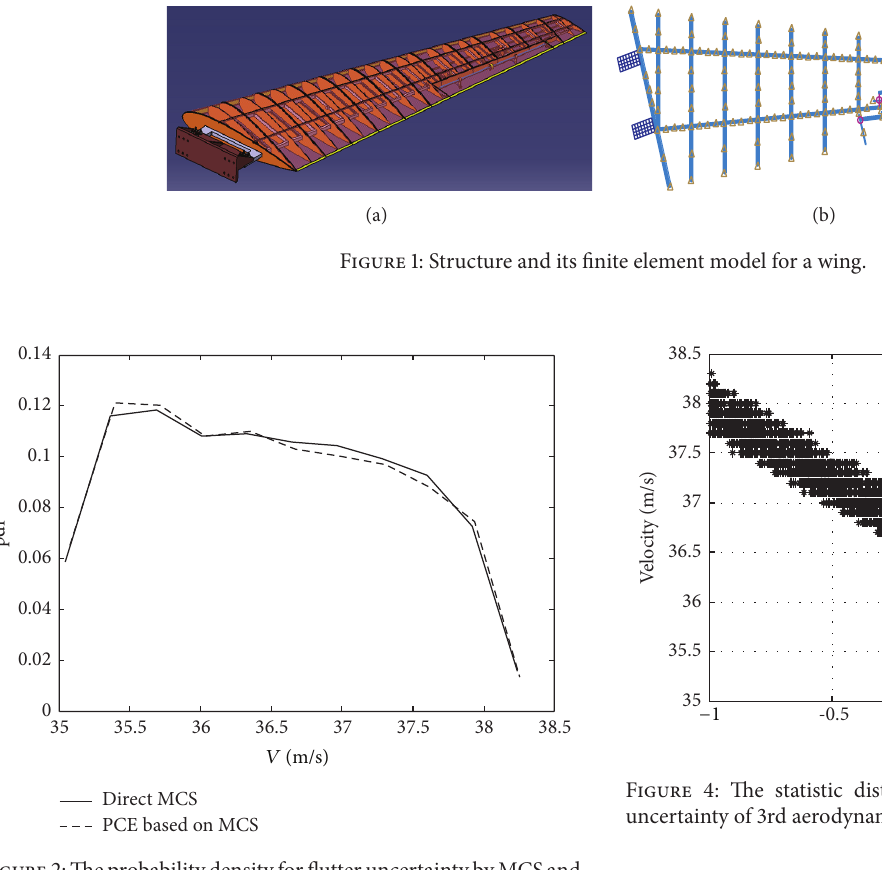
Figure 2: The probability density for flutter uncertainty by MCS and PCE.